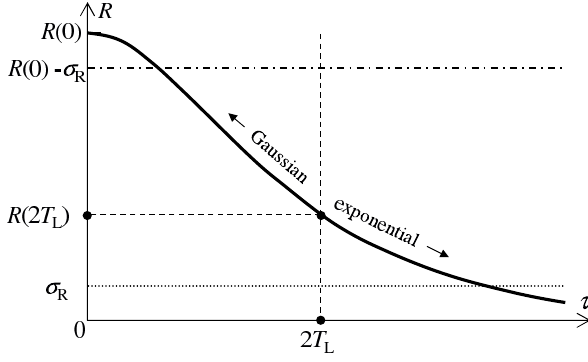
Fig. 10. Physical meaning of the Lagrangian correlation time, T L , for the model described by Eq.